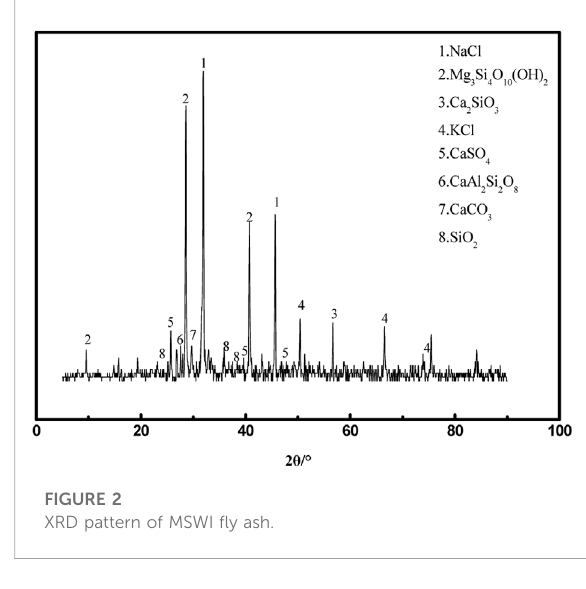
FIGURE 1 Schematic representation of the equilibrium adsorption model (C-S-H 1.7).